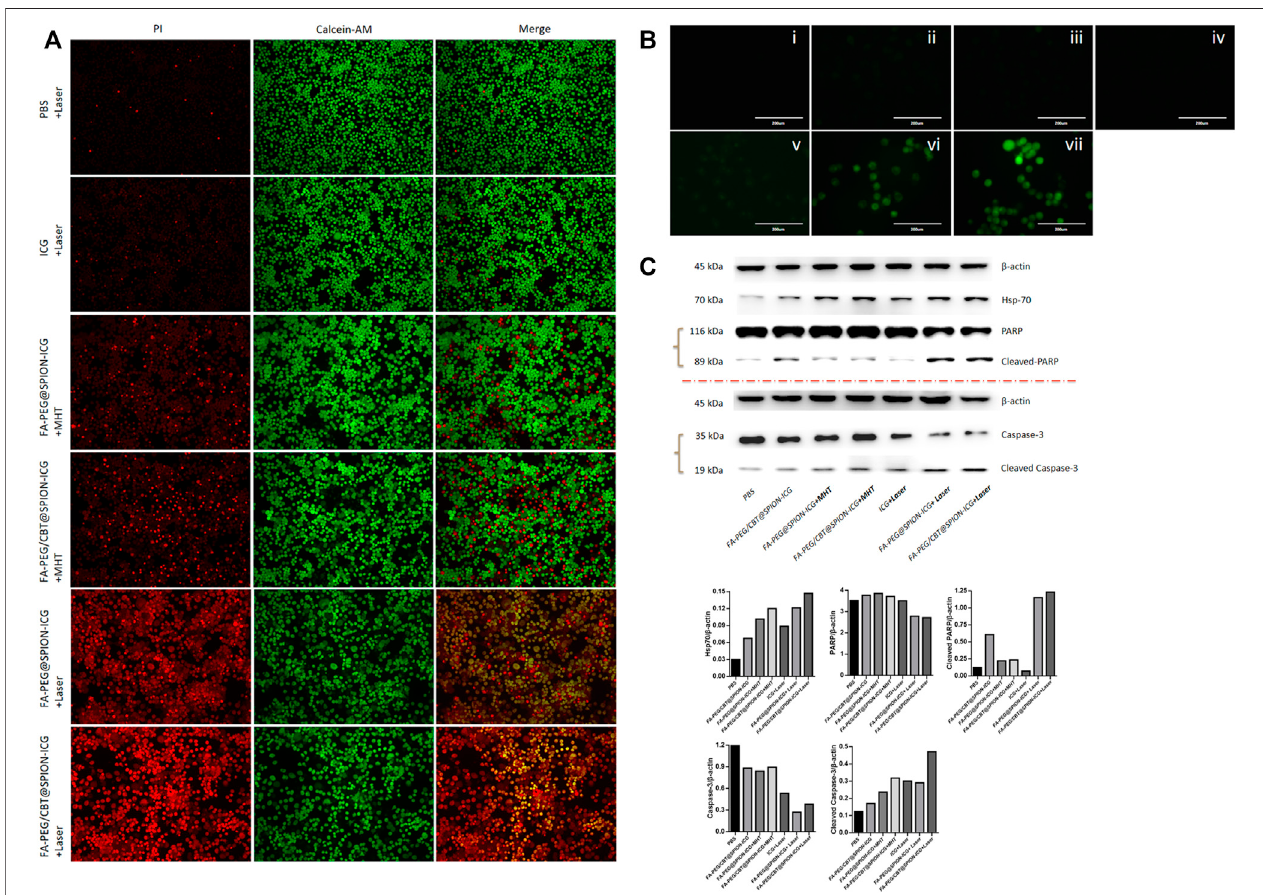
FIGURE 4 | Calcein-AM/PI live/dead cell staining (10 × ) (A) , ROS detected by DCFH-DA staining (B) , and western blot analysis (C) of different formations under variousconditions.In B ,iisPBS,iiisFA-PEG@SPION-ICG,iiiisFA-PEG/CBT@SPION-ICG,ivisPBS+Laser,visICG+Laser,viisFA-PEG@SPION-ICG+Laser,andvii is FA-PEG/CBT@SPION-ICG +